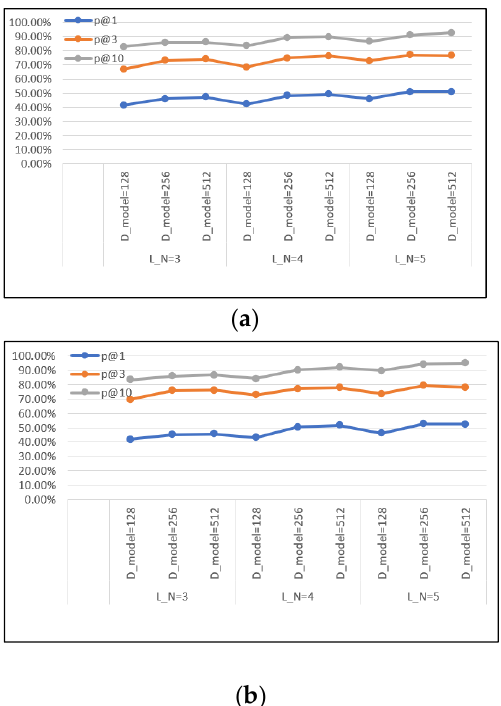
Figure 10. Comparison of training hyperparameters: ( a ) p@N in the disassembling set; ( b ) p@N in the compiling set.